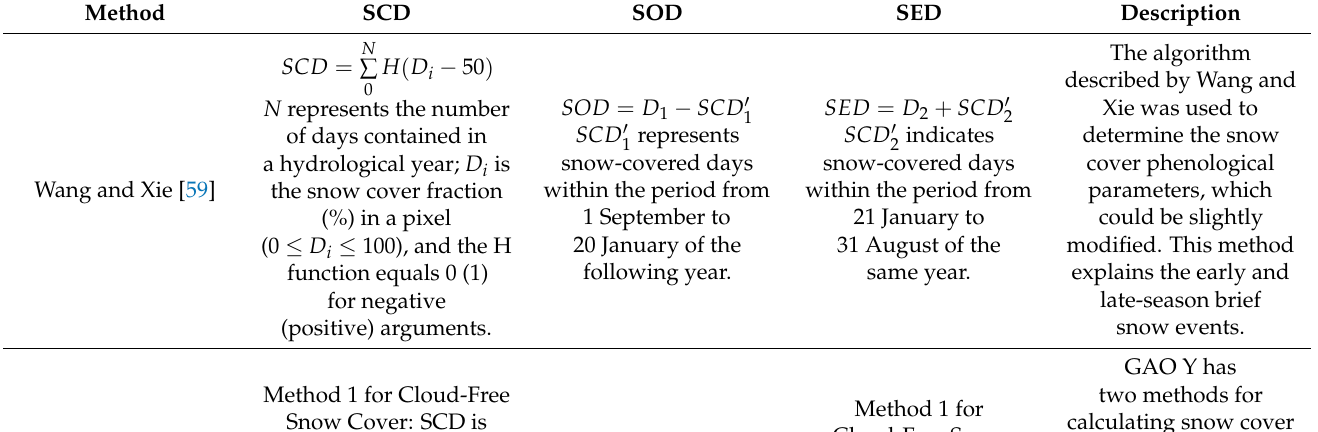
Table 2. Snow cover phenological parameter extraction